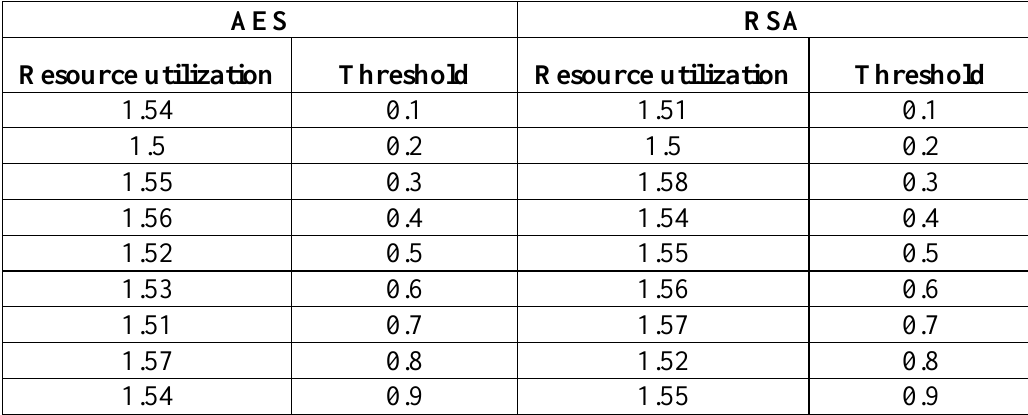
Table 7. Resource Utilization